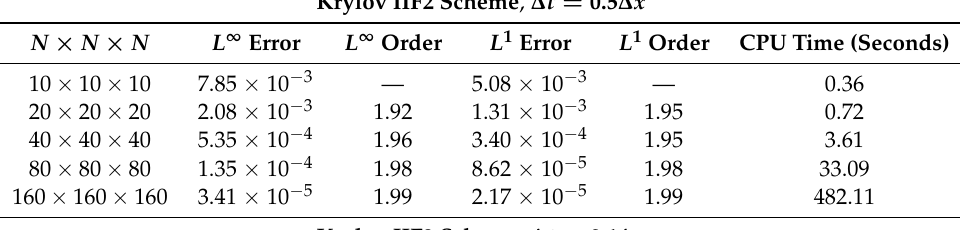
Table 5. Example 5. Fourth-order system with stiff reaction in three dimensions.CPU time, numerical errors and orders of accuracy of Krylov IIF2 and Krylov IIF3 schemes. Krylov subspace dimension: M = 10. Final time: T =